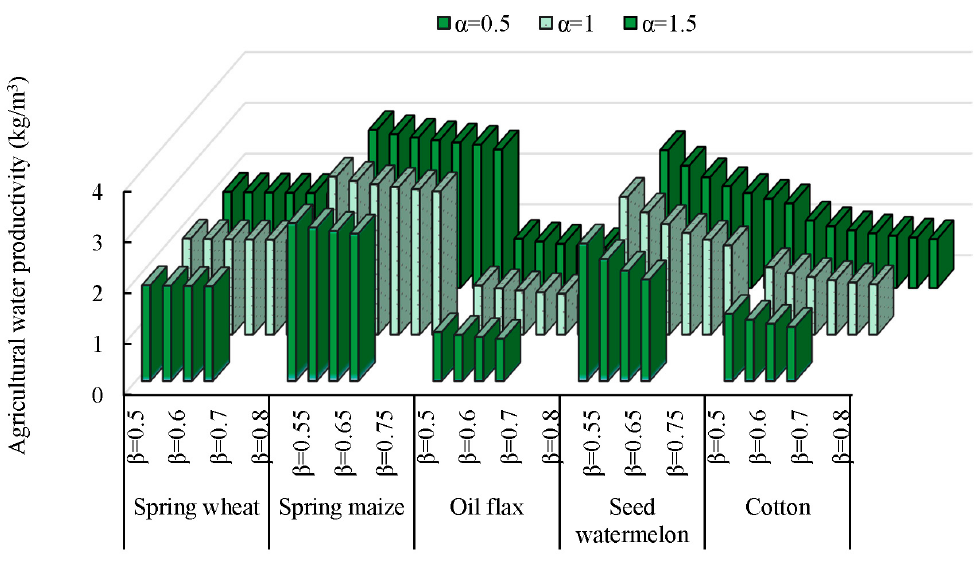
Figure 7. Agricultural water productivity for different crops under different scenarios.